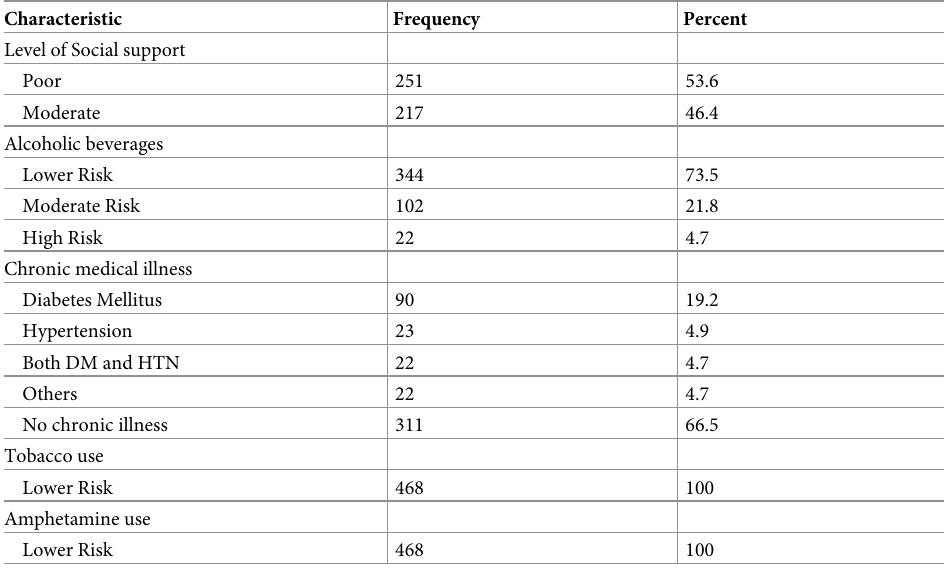
Table 2. Level of social support, substance use and comorbid medical illness among study participants.